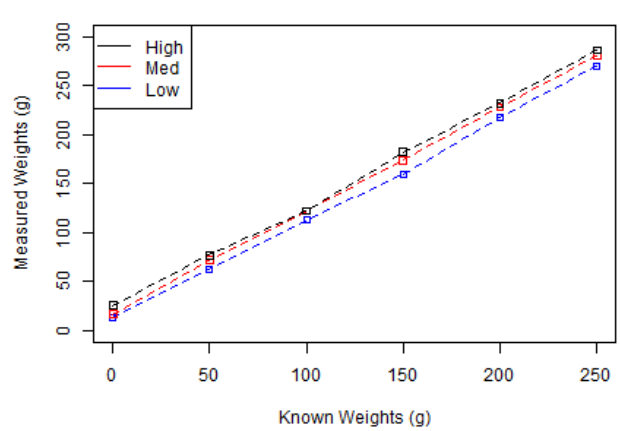
Figure 11. Difference between measured and known weights (g) at three protraction heights.